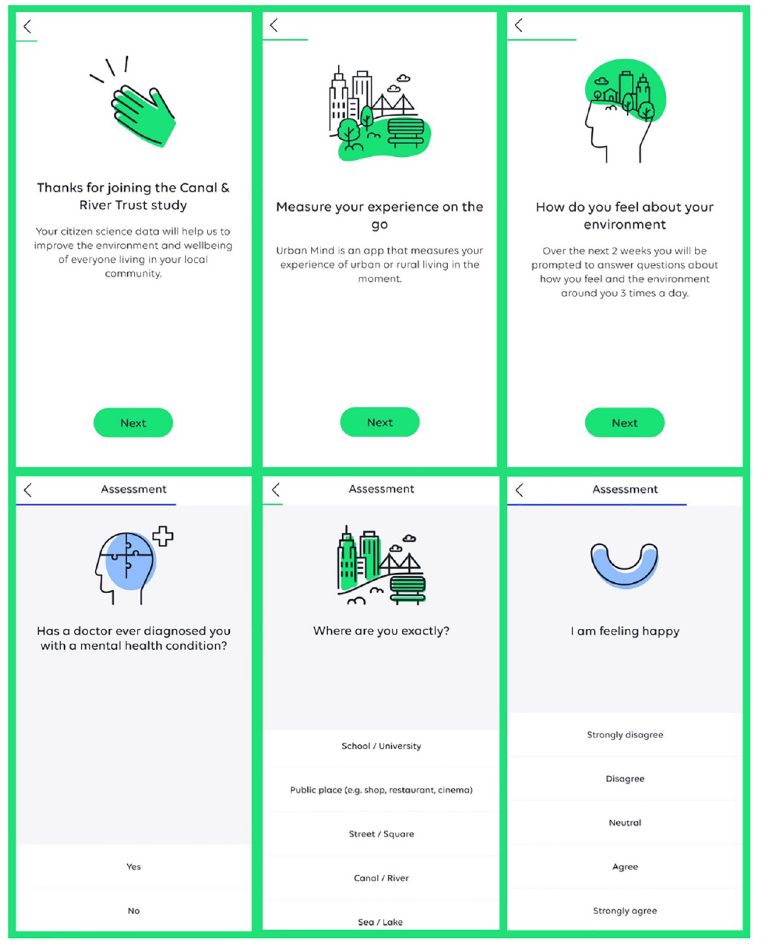
Fig 1. Screenshots of the Urban Mind app